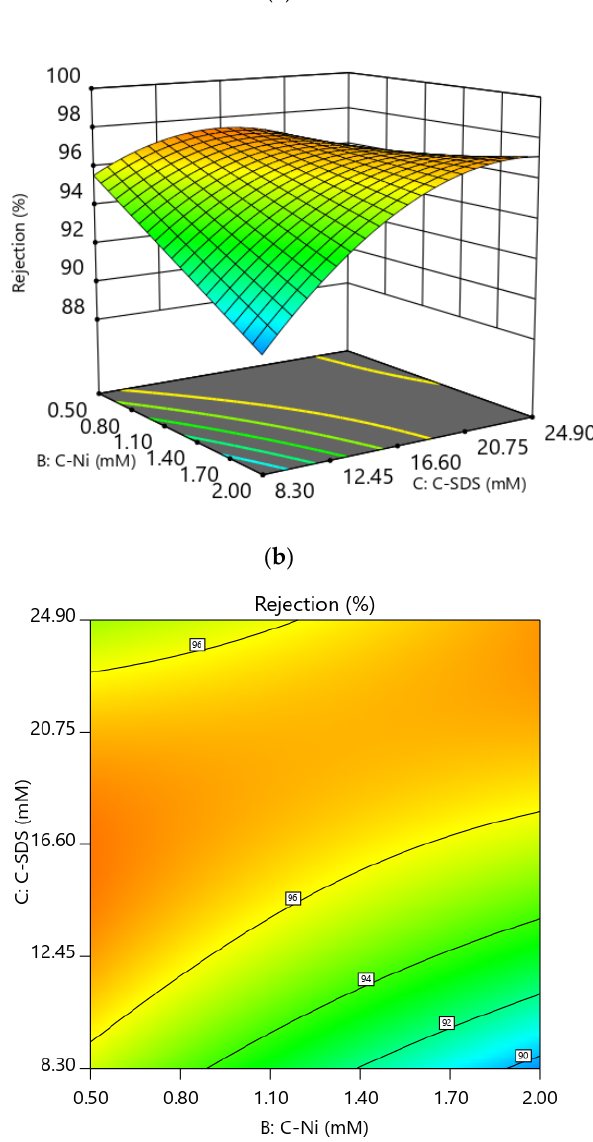
Figure 3. Response surface ( a ) and contour ( b ) showing the effect of nickel and SDS concentrations on rejection rate. Pressure = 40 psi, MWCO = 5 kDa.